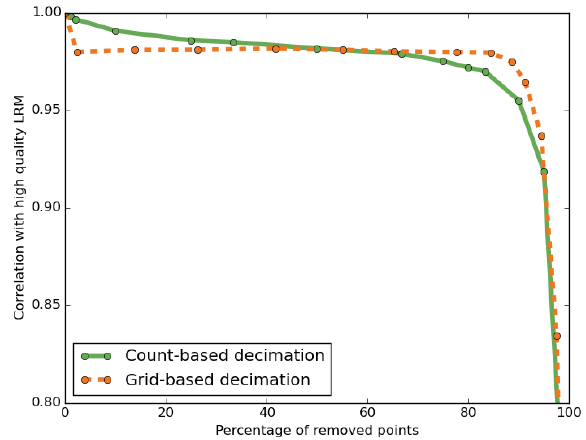
Figure 9: Comparison of the performance of count-based and grid-based decimation applied to a point cloud obtained using UAV imagery